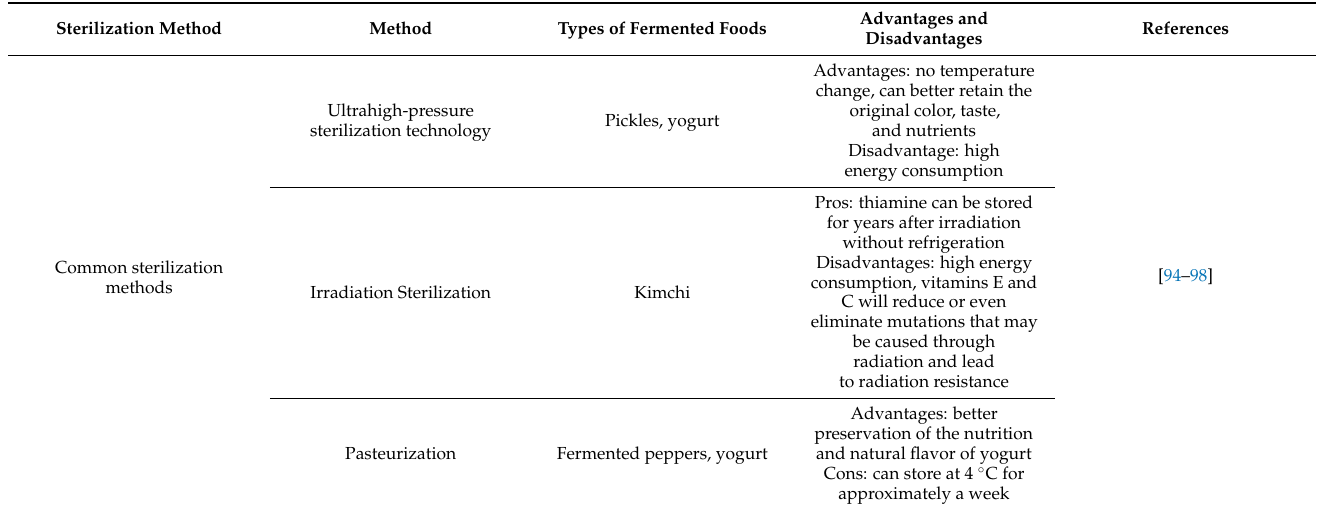
Table 2. Comparison of common sterilization methods with bacteriophage antibacterial